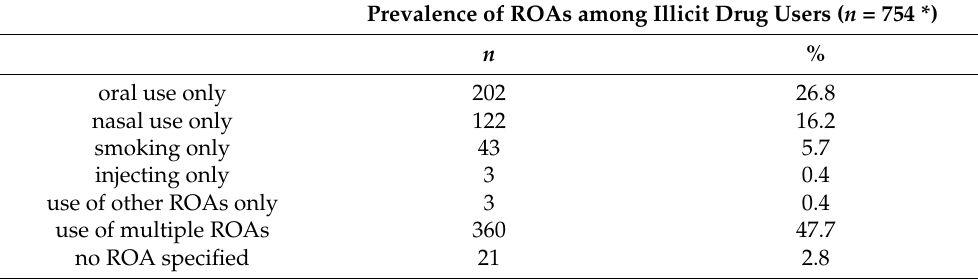
Table 2. Prevalence rates for the use of single and multiple ROAs among users of any of the 18 illicit